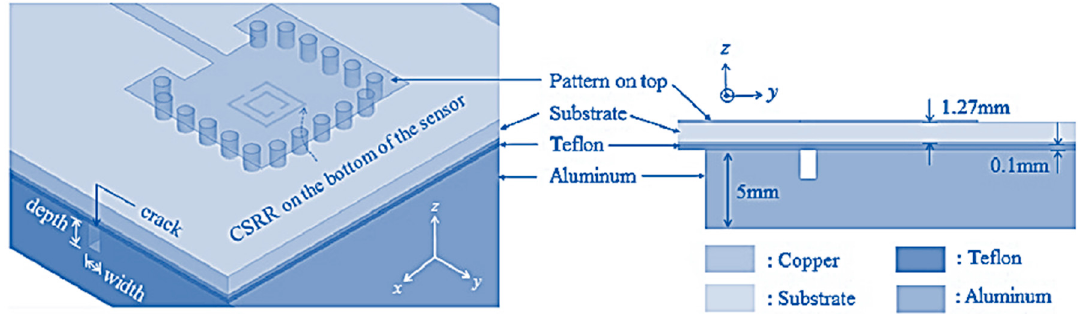
Figure 29. Measurement environment: ( a ) side view and ( b ) cross ‐ sectional view (from [41]; copyright © 2014; reproduced with permission).